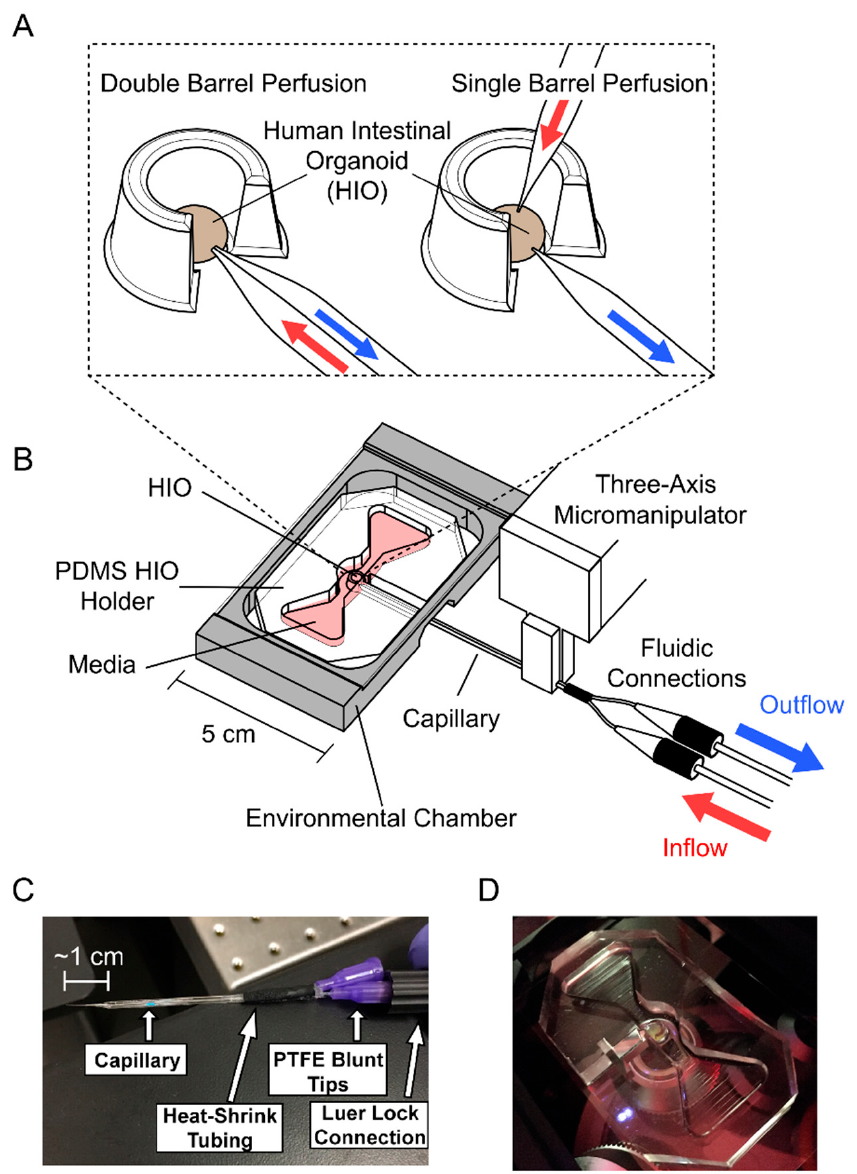
Figure 1. ( A ) A zoomed-in schematic of the human intestinal organoid (HIO) puncture strategy with one double-barreled capillary or two single-barreled capillaries. ( B ) The device utilizes a micromanipulator to position the capillary that punctures the HIO. The HIO is placed in a PDMS HIO holder to assist with the puncture and maintain environmental conditions. ( C ) A photo of a double-barreled capillary shows the components that allow for an air-tight connection with the fluidic lines. ( D ) A photo of an HIO and Matrigel within the PDMS HIO holder without